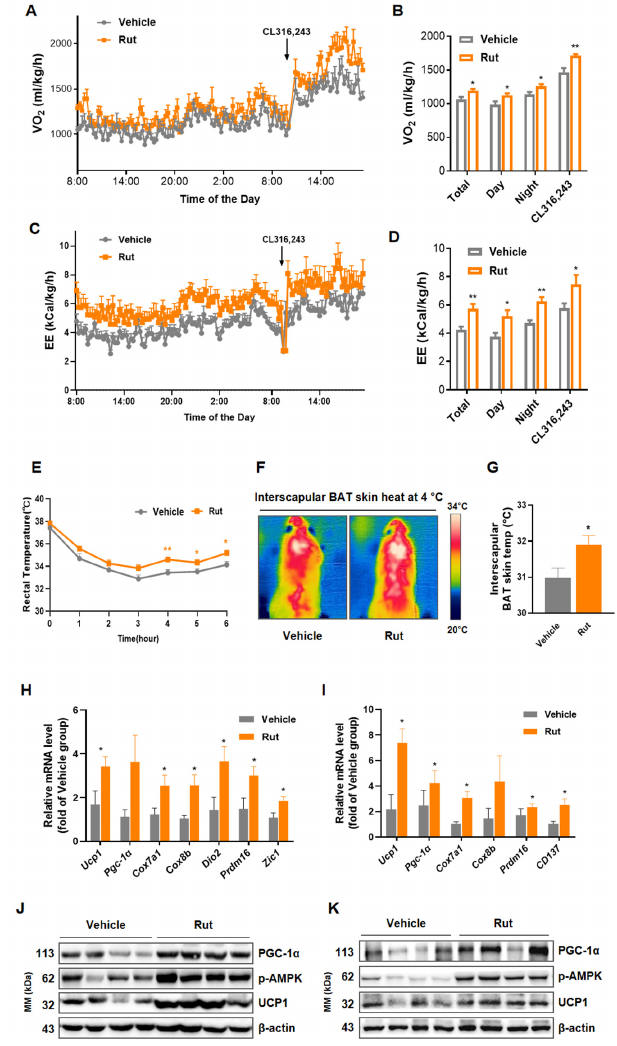
Figure 4. Rut promotes heat generation and energy expenditure in HFD-fed mice. ( A ) Monitoring of oxygen consumption (VO2). ( B ) Average O2 consumption. ( C ) Analysis of energy expenditure (EE) in 24 h and after administration of CL316,243. ( D ) Average energy expenditure. ( E ) Rectal temperatures of HFD mice were recorded every hour after transition to 4 °C from 22 °C. ( F ) Representa- tive infrared thermal images of HFD-fed mice treated with vehicle or Rut after 6 h of exposure to 4 °C. ( G ) Quantification of the interscapular BAT skin temperatures of HFD mice. ( H , I ) RT-qPCR analysis of thermogenic genes in iBAT ( H ) and iWAT ( I ) from HFD mice. ( J , K ) Western blot analysis of proteins indicated in iBAT (J) and iWAT (K). n = 4–6 per group. Data are presented as the means ±SEM. Student’s t -test. * p < 0.05, ** p < 0.01 compared with the indicated control group.